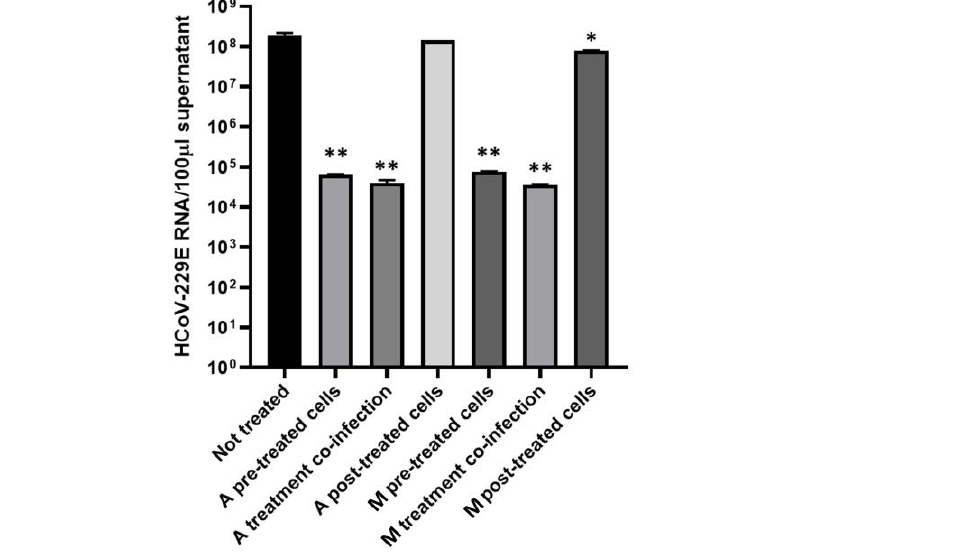
Figure 8. Real-time PCR quantification of HCoV-229E genomes per 100 µL supernatants. Human MRC-5 fibroblast cells were infected with HCoV-229E treated or untreated with N. oleoabundans extract A and M at different stages of infection. Extract A derived from autotrophic algae cultures, while extract M from mixotrophic ones. Untreated infected MRC-5 cells were used as control for viral replication. Total RNA was extracted from supernatants collected after 48 h of infection, and viral RNA released in medium was quantified by real-time PCR after reverse transcription. Values are reported as means ± standard deviations ( n = 3). *, p ≤ 0.05; **, p ≤ 0.01.